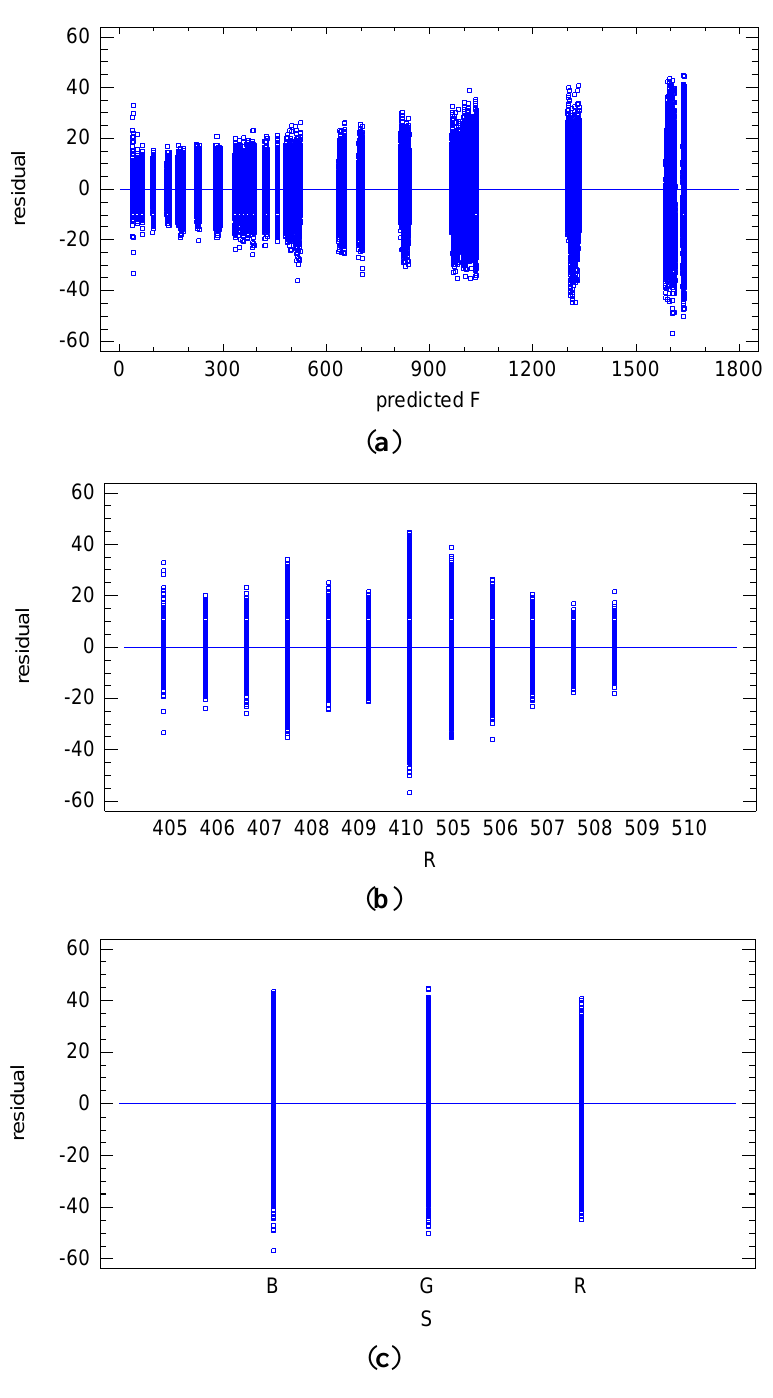
Figure 4. ( a ) Residuals vs. adjusted radiometric values F illustrating the heterogeneity of the residuals; ( b ) Residuals vs. reflectance factor r (Note that factor r is a categorical factor); ( c ) Residuals vs . wavelength factor S